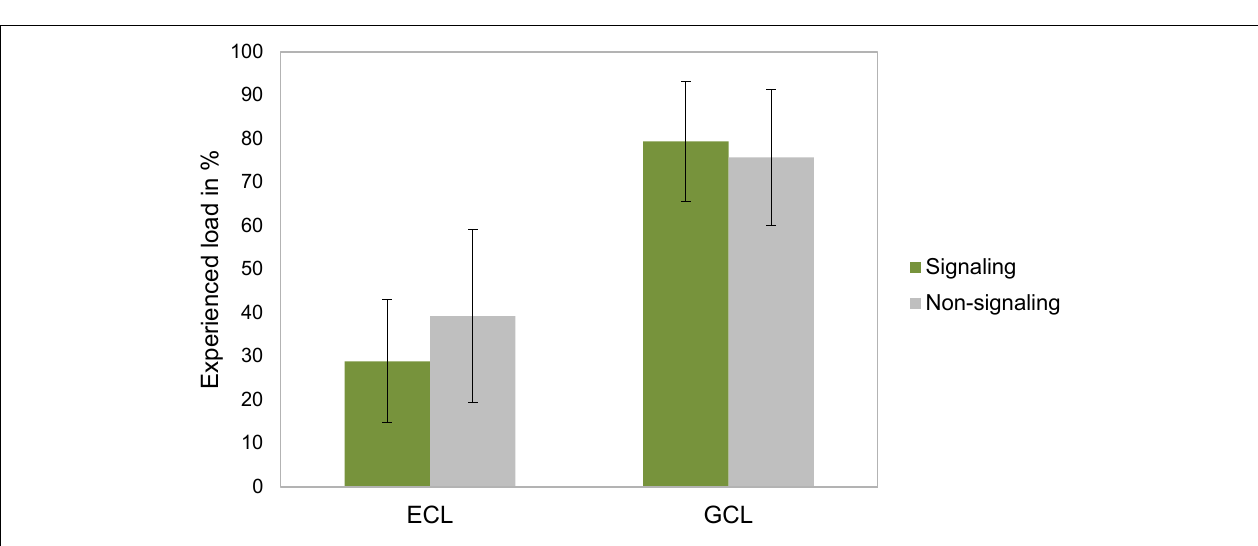
FIGURE 3 | Mean values (in percent) for ECL, and GCL, separately for the signaling and non-signaling group. The vertical error bars indicate the standard error of the mean; ECL, extraneous cognitive load; GCL, germane cognitive